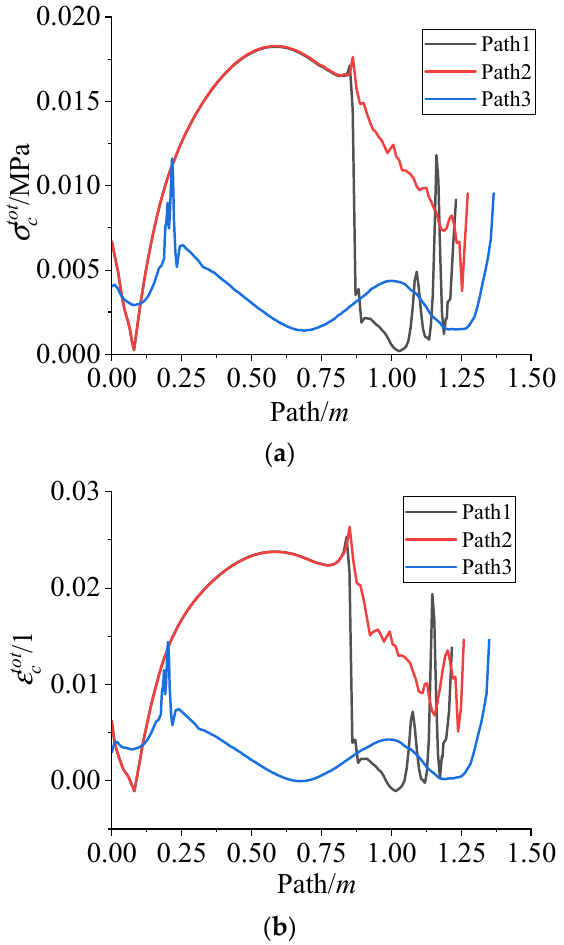
σ varies along path 1~3. ( b ) The tot c c varies along path 1~3. ( b ) The ε